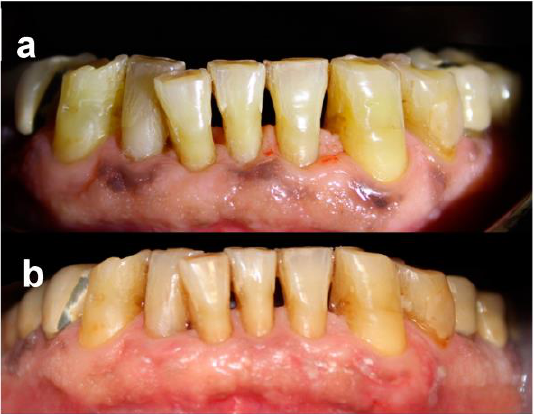
Figure 2. Patient no. 1: Preoperative clinical aspect ( a ) and follow-up 1 year after laser application (one session) ( b ).